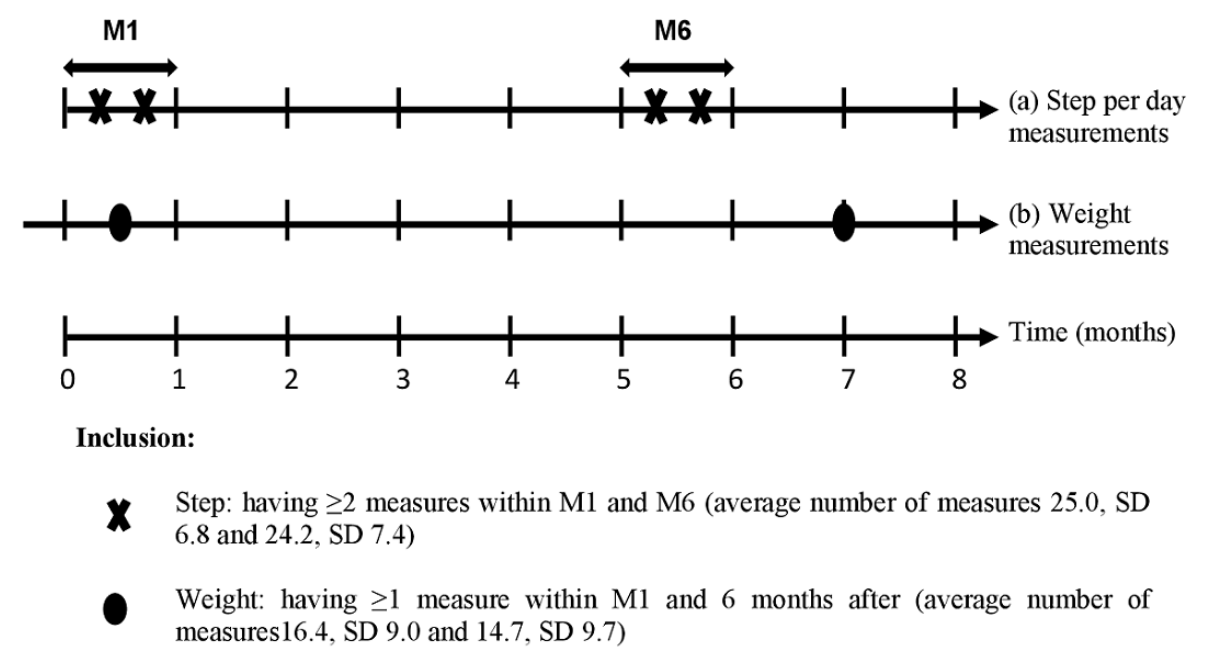
Figure 1. Follow-up and inclusion criteria of the study (N=26,935). (a) Step per day measurements were obtained through the Withings Pulse activity tracker. (b) Weight was assessed by users on their Withings weight scale. M1: first 30-day period of activity tracker use; M6: sixth 30-day period of activity tracker